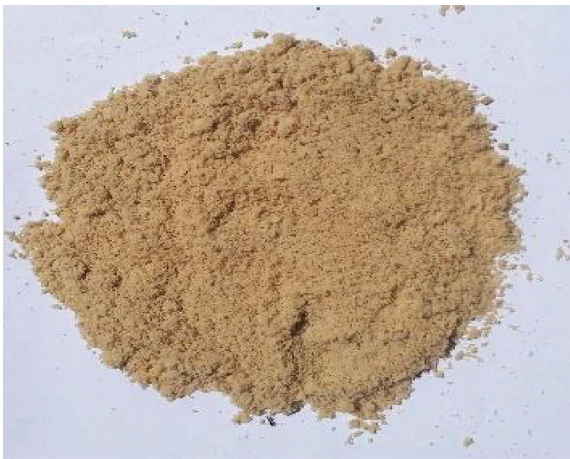
Figure 3: Crushed C. M.